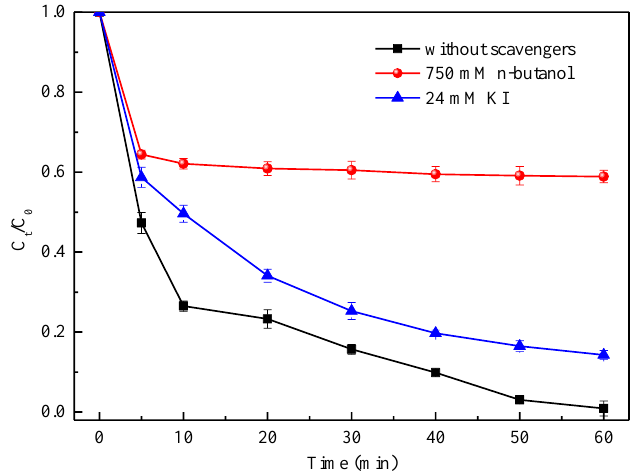
Figure 8. Effect of radical scavengers on TC removal. C 0 (mg/L) and C t (mg/L) are the TC concentra- tions at the initial time and at time t , respectively. Conditions: C 0 = 50 mg/L; CMC-FeS dosage = 15 mg/L; CMC-to-FeS mass ratio = 1:2; initial pH = 7.0; t hermostatic oscillator (150 rpm, 25 ± 1 °C ).